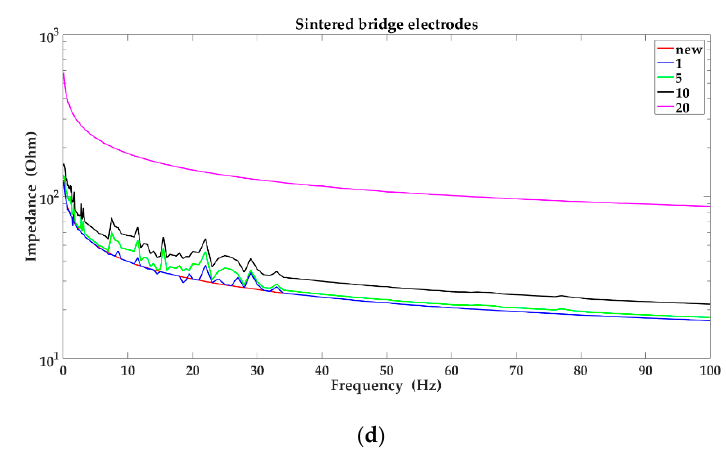
Figure 4. Impedance characteristic of the electrodes: ( a ) gold; ( b ) silver; ( c ) silver/silver chloride; ( d ) sintered bridge electrodes; before the first use, after the first, the fifth, the tenth and the twentieth EEG examinations, respectively.